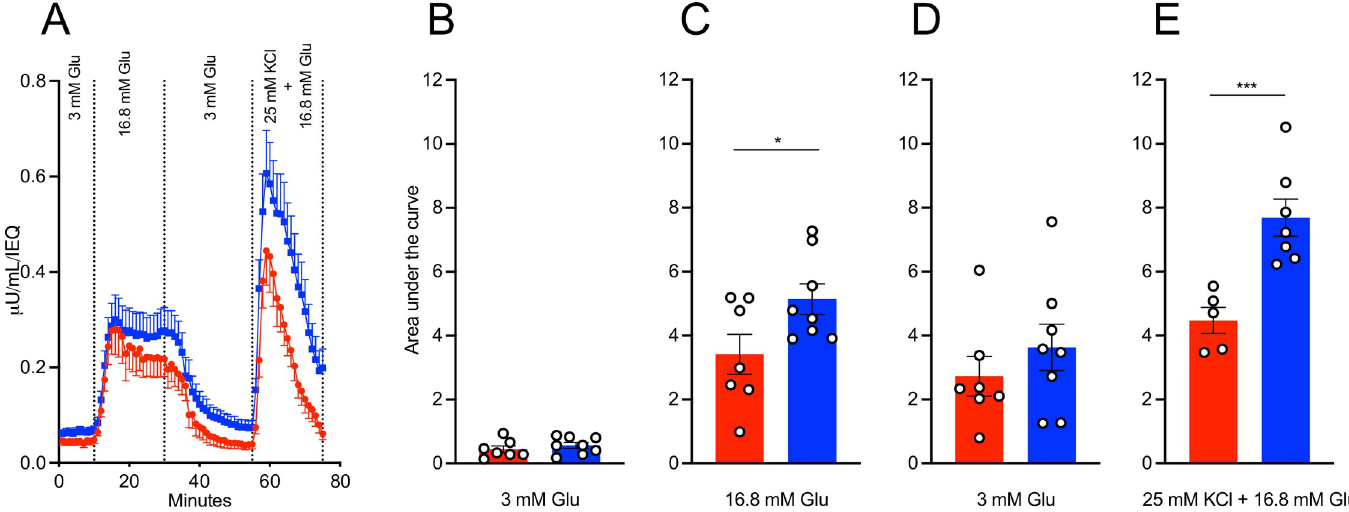
Fig 1. Islets from chronic marijuana-users have lower responses upon in vitro challenge with secretagogues. (A) Isolated islets from chronic marijuana-users (red) and non-users (blue). After 48 hours of culture, islets were perifused sequentially with Krebs-Ringer’s Buffer Solution (pH 7.4) containing 3 mM glucose, 16.8 mM glucose, 3 mM glucose, and 25 mM KCl plus 16.8 mM glucose, respectively. Insulin secretion was quantified by ELISA and standardized by islet IEQ number. Area under the curve of secreted insulin on perifusion with (B) 3 mM glucose; (C)16.8 mM glucose; (D) 3 mM glucose; (E) 25 mM KCl plus 16.8 mM glucose in panel A. Marijuana-users (n = 7) and non-users (n = 8). � p < 0.05; ��� p < 0.001. All analyses were performed using GraphPad Prism version 8.0. A p < 0.05 was considered significant. The values are expressed as the mean ±